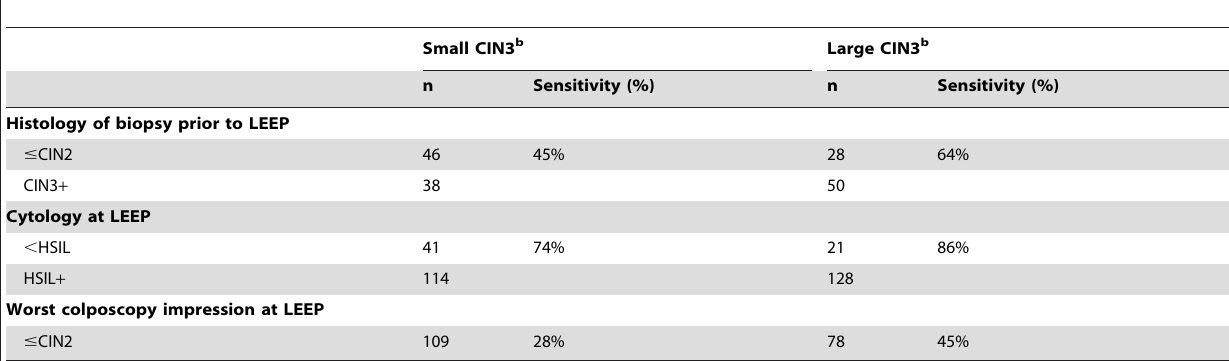
Table 4. Comparison of sensitivity of detecting small versus large CIN3 lesion by diagnostic tests among women in SUCCEED diagnosed as CIN3 by LEEP (N =309) a